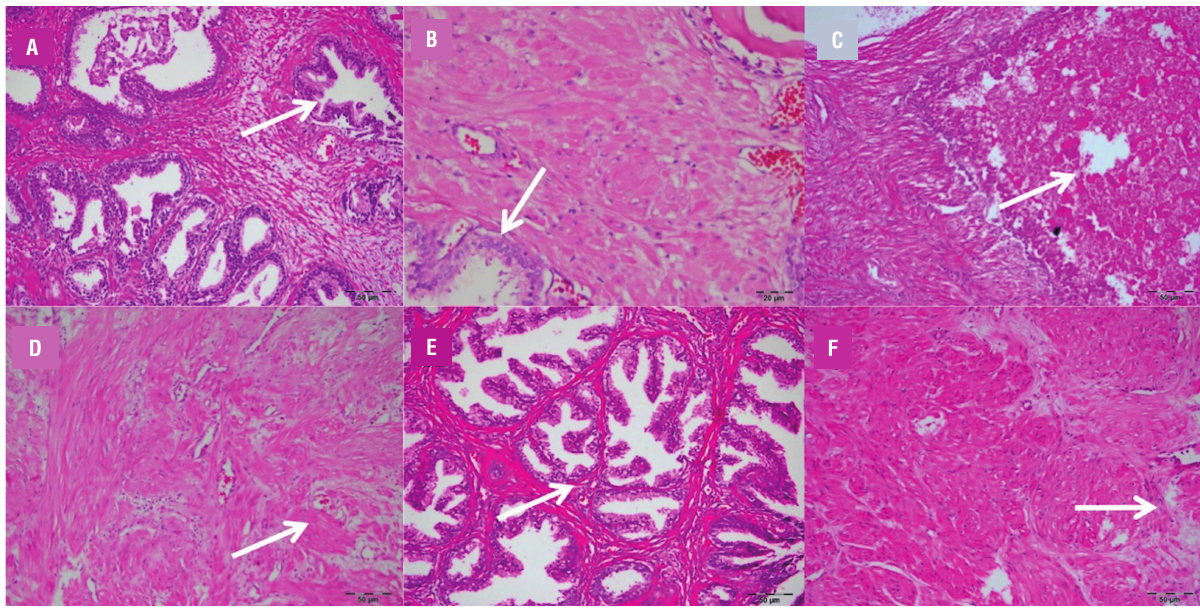
figure 1 - The Haematoxylin-Eosin dyed view of groups. A) The arrow shows glandular reproduction and inflammation in cells of Group-1, B) The more decreased level of inflammation was observed in Group-2 with Haematoxylin-Eosin dying. c) The arrow shows glandular hyperplasia in Group-3, D) The arrow shows glandular hyperplasia with mild amyloid deposition in Group-4, E) The arrow shows glandular hyperplasia with intertubular of lymphocytes and macrophages were creating inflammation in Group-5, f) The most inflammation was observed in